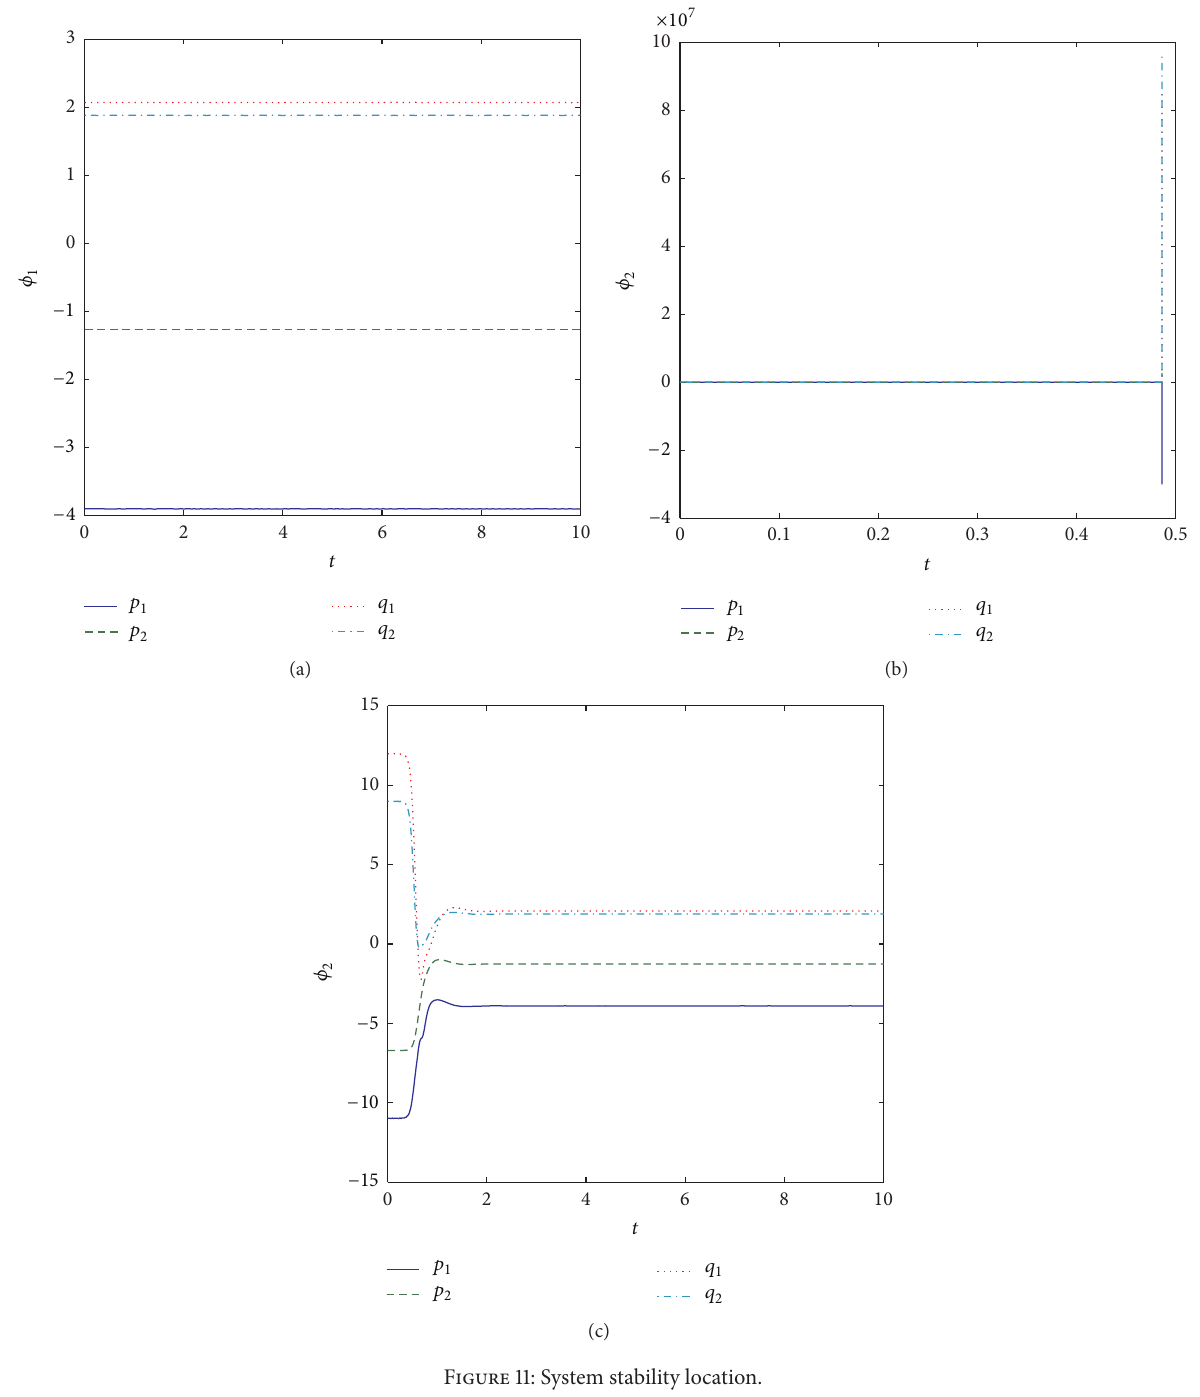
Figure 11: System stability